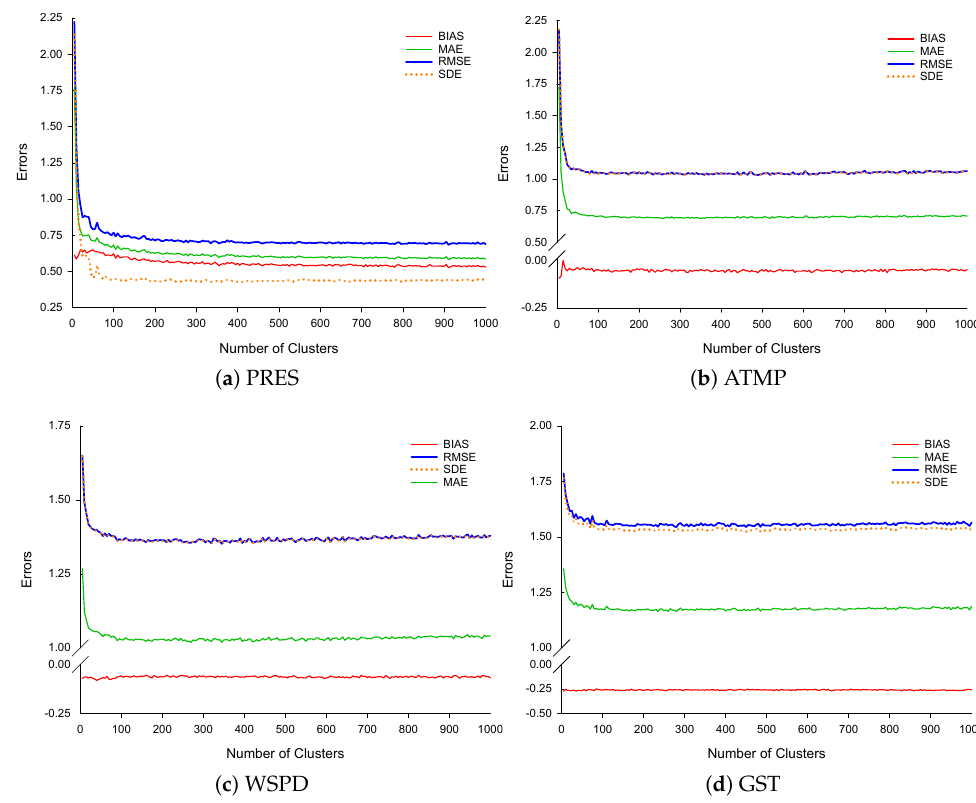
Figure 3. Prediction errors as a function of the number of clusters ( N c ).